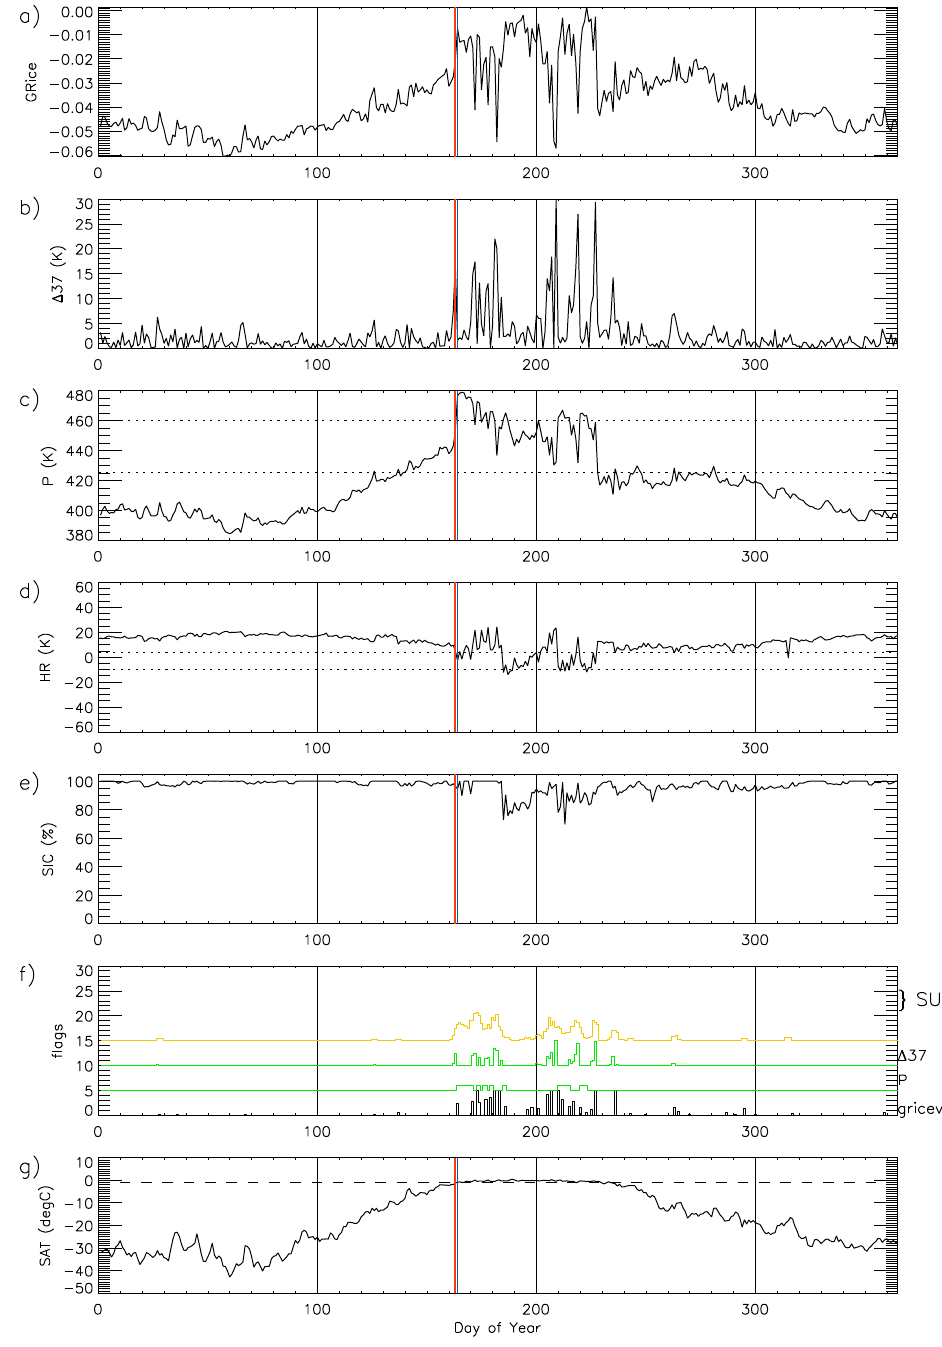
Figure 4. PMW MO parameters (( a ) Δ GR ice , ( b ) Δ 37V, and ( c ) P), ( d ) AHRA HR, ( e ) NASA Team sea ice concentration, ( f ) PMW weighting flags (see text for details), and ( g ) POLES SAT from 1994 for case study location in the central Arctic (82.9°N, 124.8°W). MO dates from AHRA (blue, obscured by SAT), PMWC (red), and first instance of SAT >0 °C (green) are shown as vertical lines.